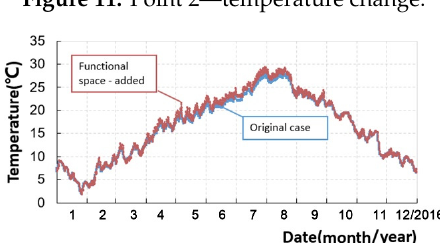
Figure 11. Point 2—temperature change.